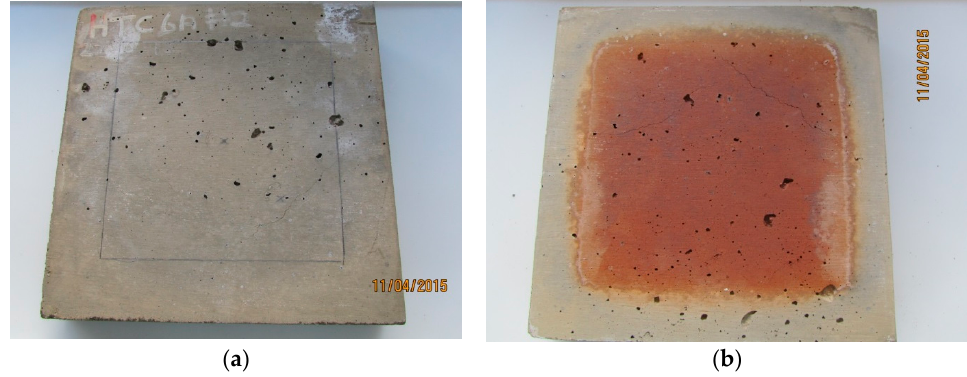
Figure 11. HTC 6A fire test images: ( a ) HTC 6A cold side after fire test; ( b ) HTC 6A hot side after fire test showing few minor cracks.